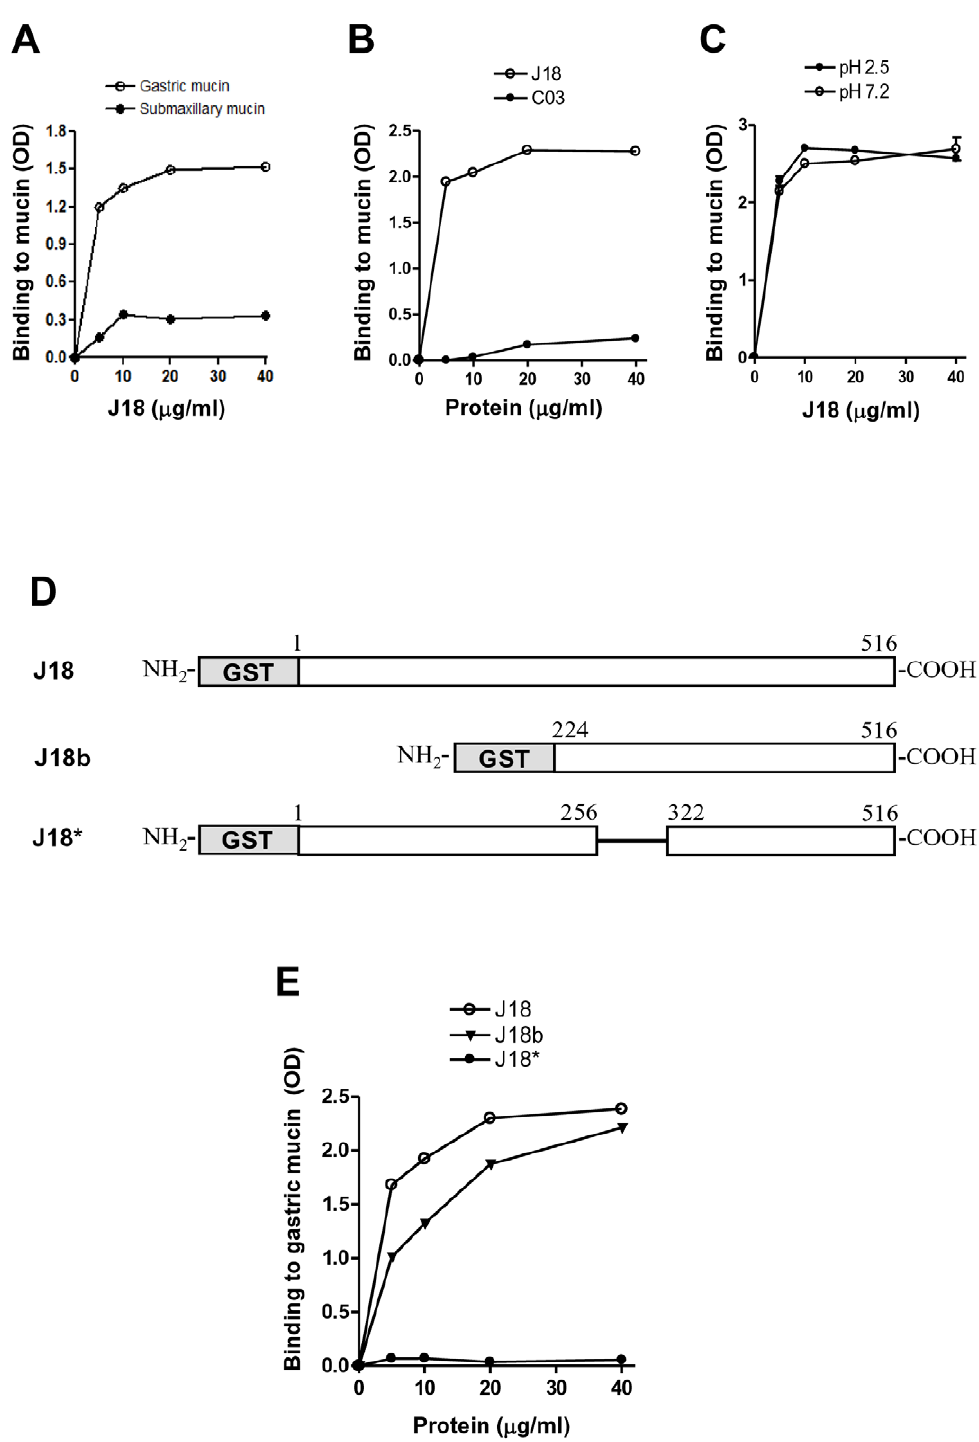
Figure 2. Specific binding of the recombinant protein J18 to gastric mucin through its central domain. A) The recombinant protein J18, containing the full length T. cruzi gp82 peptide sequence, was added to microtiter plates coated with gastric or submaxillary mucin at the indicated concentrations. Values are the means of triplicates of one representative assay out of three. Variation between triplicates was , 5%. (B) C03, a recombinant protein of T. cruzi gp82 family with 59.1% identity with J18, was used for gastric mucin-binding assay. C) Gastric mucin preparations at pH 2.5 and pH 7.2 were used to coat microtiter plates and then binding of J18 was performed. In (B) and (C), the values are the means of triplicates (variation , 5%). D) Schematic representation of recombinant proteins based on gp82 molecule. Shown are the GST-fused constructs containing the full-length gp82 sequence (J18) or lacking either the amino-terminal portion (J18b) or the central domain spanning residues 257–321 (J18*). E) Binding of J18, J18b and J18* to gastric mucin was compared. Values are the means of triplicates (variation , 10%).